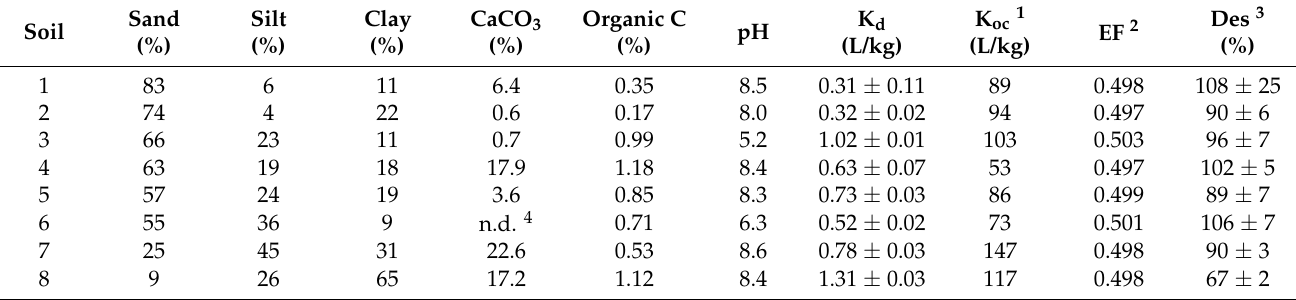
Table 1. Soil properties and coefficients for rac-pulegone